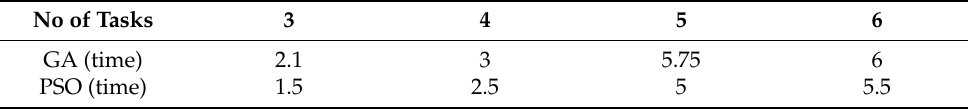
Table 16. Approximate comparison of cost to complete tasks. No of Tasks 3 4 5 GA (cost) 20 PSO